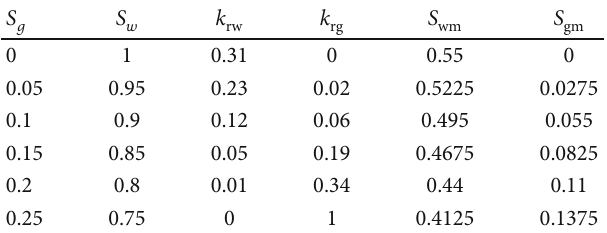
Table 1: Relative permeability curves for reality and modi fi cation. S S g w